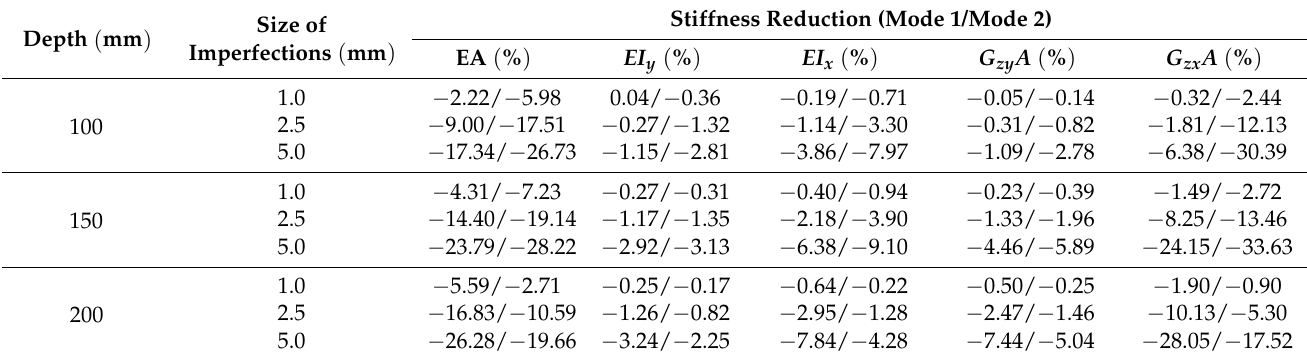
Table 2. Stiffness reduction of the Z profile depending on the elongation depth (beam axis) and buckling mode in compression.